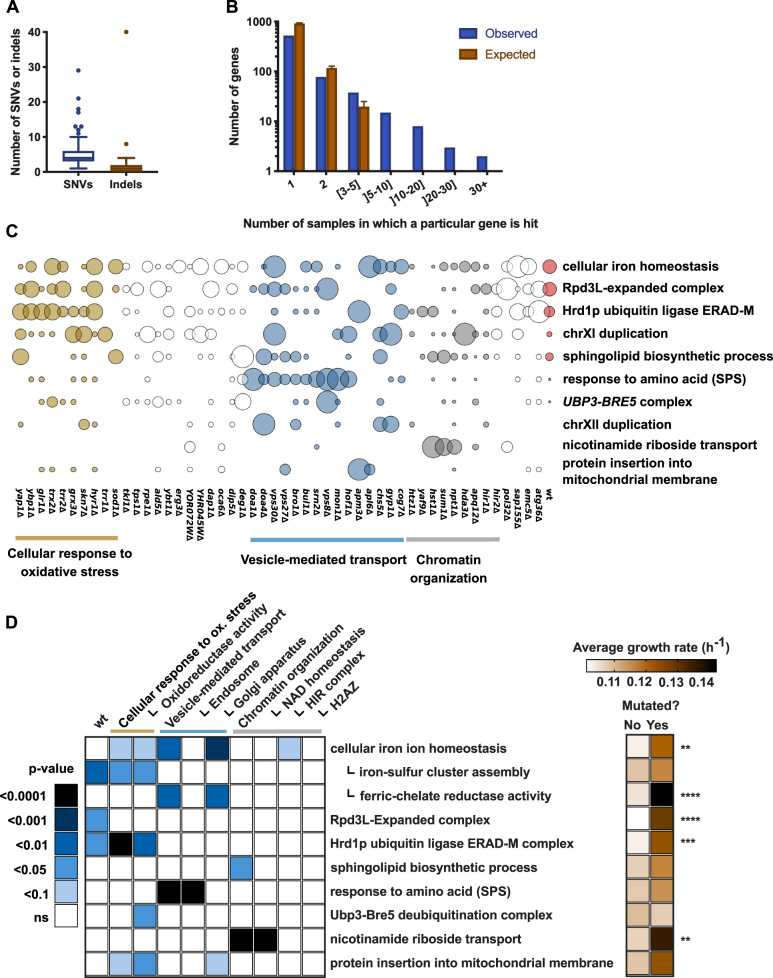
Evolution is convergent at the level of modules and individual genes. (A) Number of SNVs and indels per sequenced sample. (B) Number of times a particular gene is hit across the sequenced samples, compared with what would be expected by chance. (C) Overview of the cellular processes (GO terms) that are mutated more often than expected by chance across all samples (supplementary table 7, Supplementary Material online), and two of the most frequently duplicated chromosomes. The size of the circles represents the fraction of independently evolved clones with a mutation in the indicated gene or pathway. (D) Specificity of each mutated process for the original genetic background and its influence on growth rate. The left side of the figure shows how often each mutated process (rows) is found within the original genetic backgrounds (columns), the latter of which are represented by genetic modules of the deleted genes. P-values represent enrichment scores and were calculated using a competitive gene set overrepresentation test as calculated by the camera function of the edgeR package. The right side of the figure shows the effect of having a mutation in one of these processes on the growth rate of the evolved strains. The average growth rates are calculated across all evolved lineages. **P < 0.01, ***P < 0.001, ****P < 0.0001 (Student’s t-test).